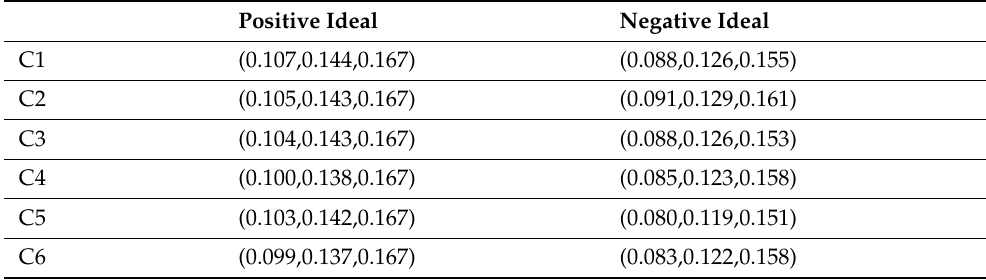
Table 6. The positive and negative ideal solutions.